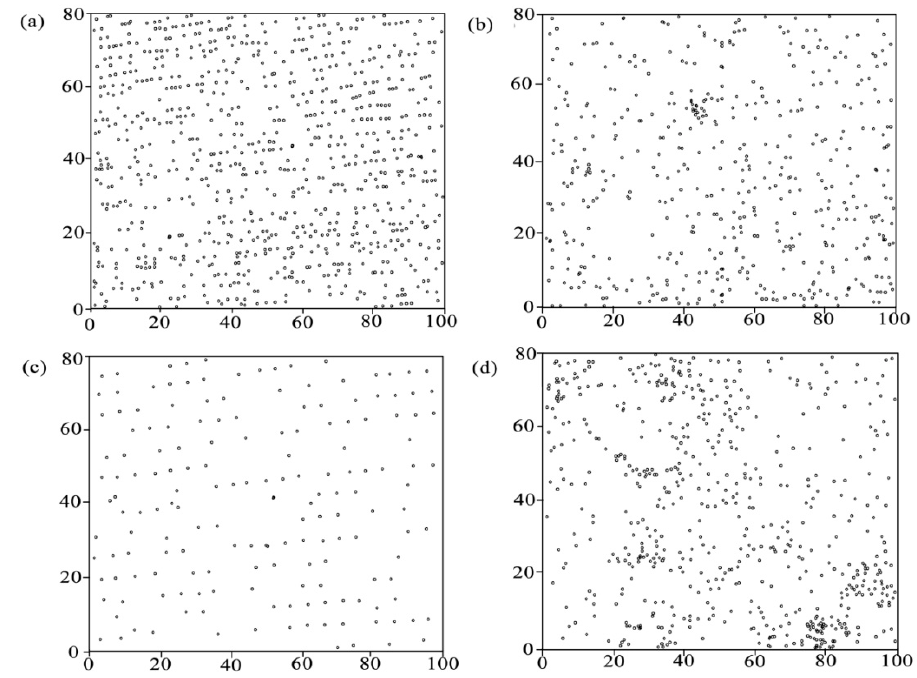
Figure 2. Distribution of each tree species in an 8000-m 2 reclaimed plot after 17-year succession in Pingshuo opencast mine, China, ( a ) planted R. pseudoacacia , ( b ) seeded-in R. pseudoacacia , ( c ) P. tabuliformis , ( d ) U. pumila . Axis scale is in meters.